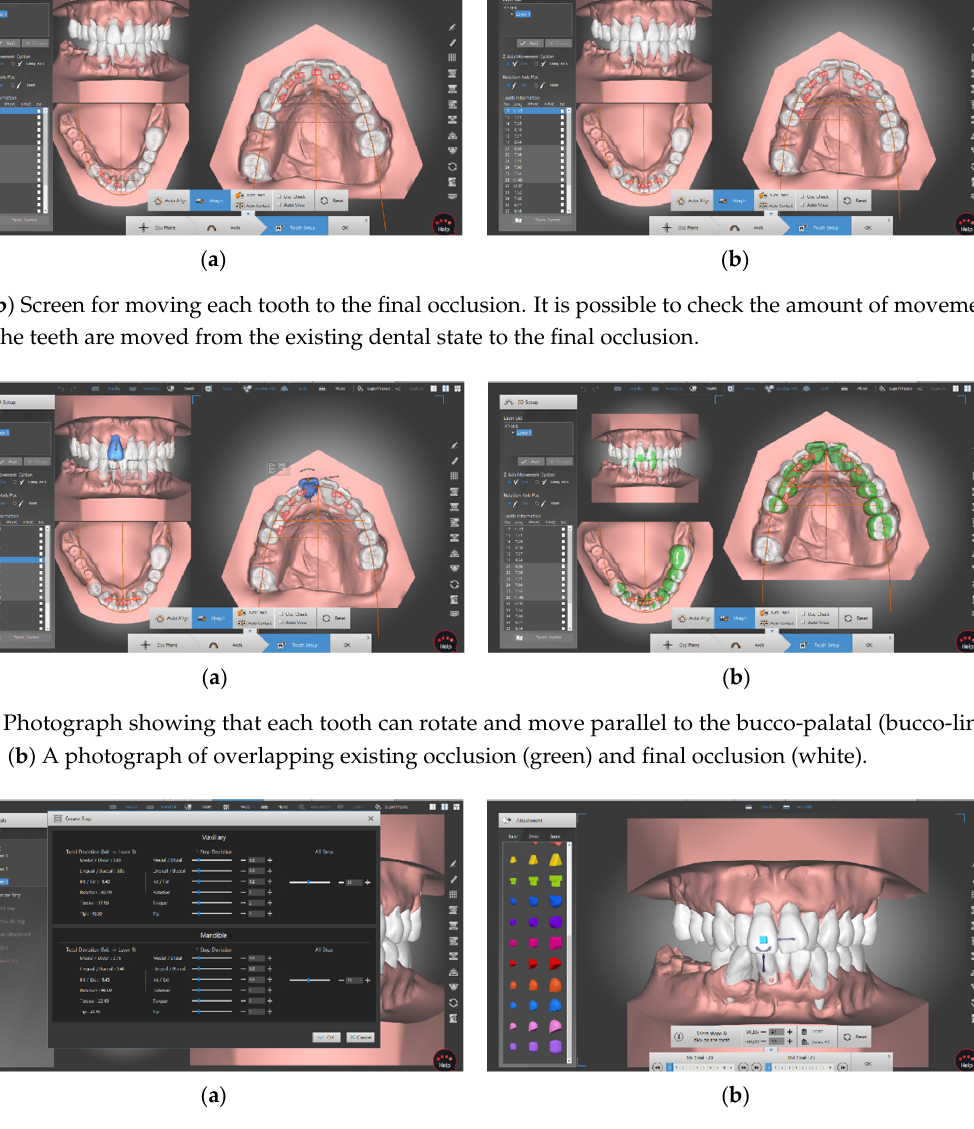
Of the 15 patients (11 males, 4 females, mean age: 22.6 ± 4.36), 5 patients (5 males, 0 females, mean age: 22.2 ± 1.33) received preoperative orthodontic treatment with clear aligners, and the remaining 10 patients (6 males, 4 females, mean age: 24.0 ± 7.86) received orthodontic treatment with traditional fixed appliances as a control group. Only one pa- tient in the clear aligner group underwent Le Fort I osteotomy and mandibular bilateral sagittal split osteotomy surgery, and the remaining 14 patients had only mandibular bi- lateral sagittal split osteotomy surgery. There was no significant difference between the two groups, although the preopera- tive orthodontic period was longer in those who received orthodontic treatment with clear aligners than those who received orthodontic treatment with traditional fixed appliances (e.g., braces) (Table 2). The number of extractions of premolars and the number of im- pacted teeth was also smaller in the group treated with clear aligners, but there was no significant difference between the two groups (Table 2). To evaluate postoperative stability, six measurement variables were compared be- tween the two groups, but no significant difference was found (Table 3). Table 2. Preoperative orthodontic period, number of premolar extraction teeth, and number of im- pacted teeth between clear aligner group and traditional fixed appliance (e.g., bracket) group. Clear Aligners (n = 5)